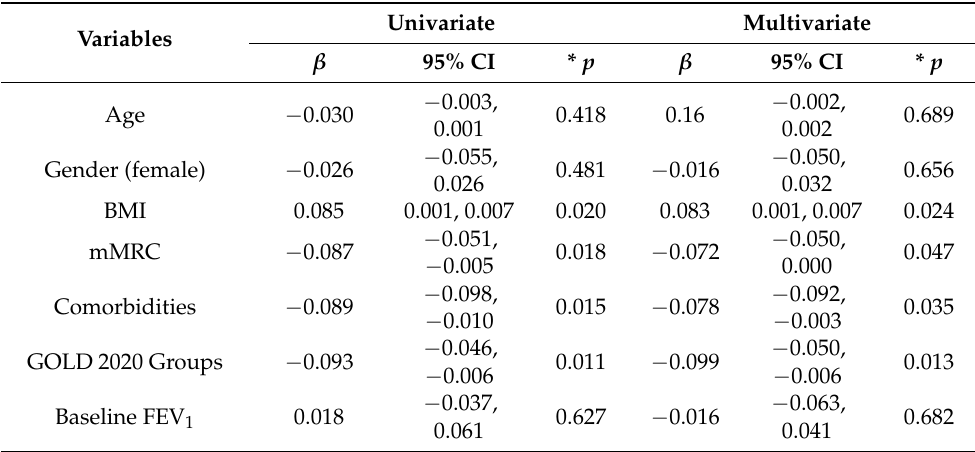
Table 5. Univariate and multiple linear regression analysis of FEV 1 change between baseline visit and 12 months after